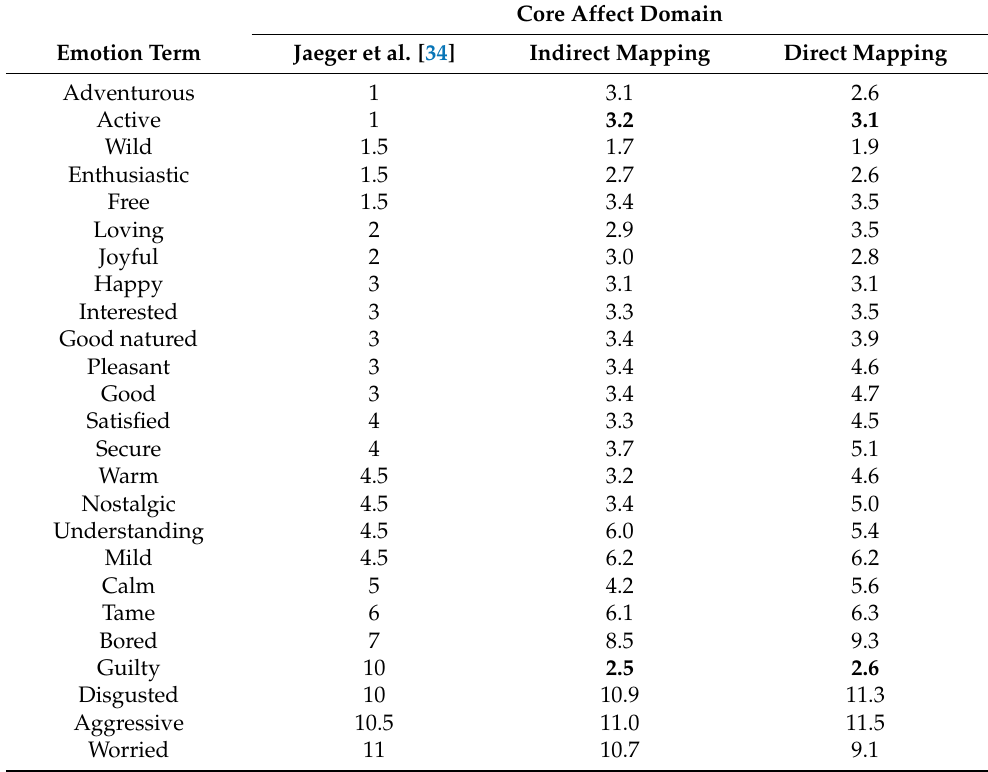
Table 3. Mapping between the EsSense25 emotion terms and the 12 domains of the core affect model presented by Yik et al. [27], from the study by Jaeger et al. [34] and obtained in this study through both direct mapping ( Label2Grid task) and indirect mapping ( Label2Image2Grid ). Fractional numbers correspond to relative positions within domains (see text). Numbers in boldface indicate mappings obtained in this study that consistently differed more than two domains from those reported by Jaeger et al. [34]. Core Affect Domain Emotion Term Jaeger et al. [34] Indirect Mapping Direct Mapping